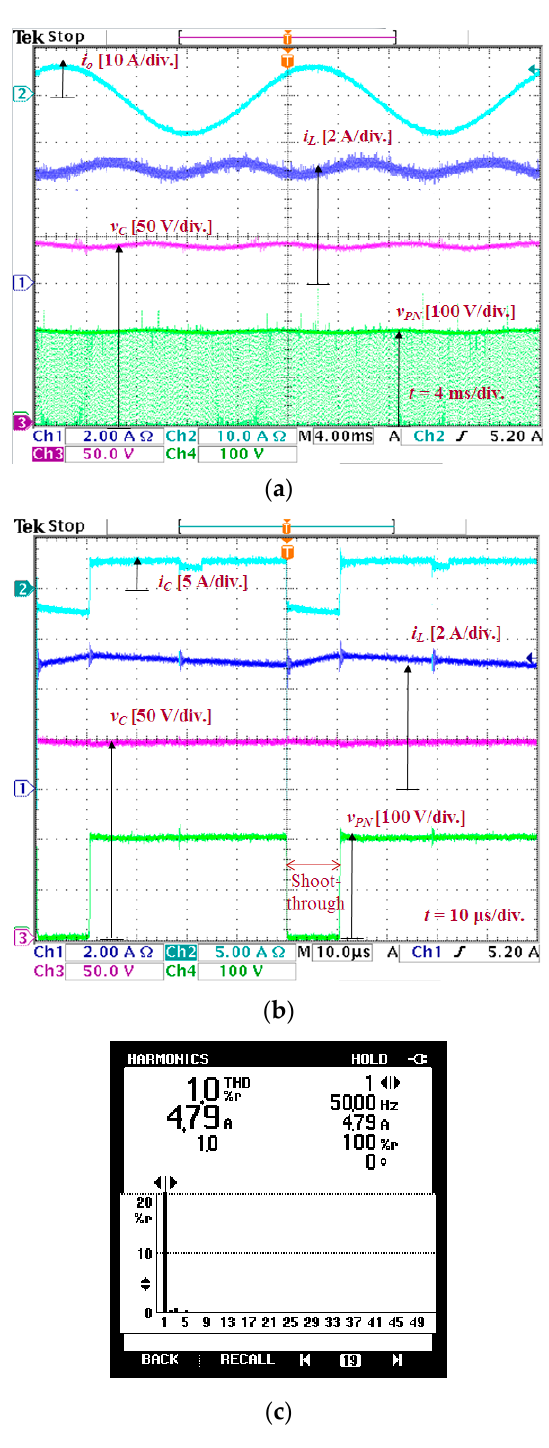
Figure 8. From top to bottom: ( a ) load current, inductor current, capacitor voltage, DC-link voltage; ( b ) capacitor current, capacitor voltage, inductor current, DC-link voltage; and ( c ) load current harmonics.